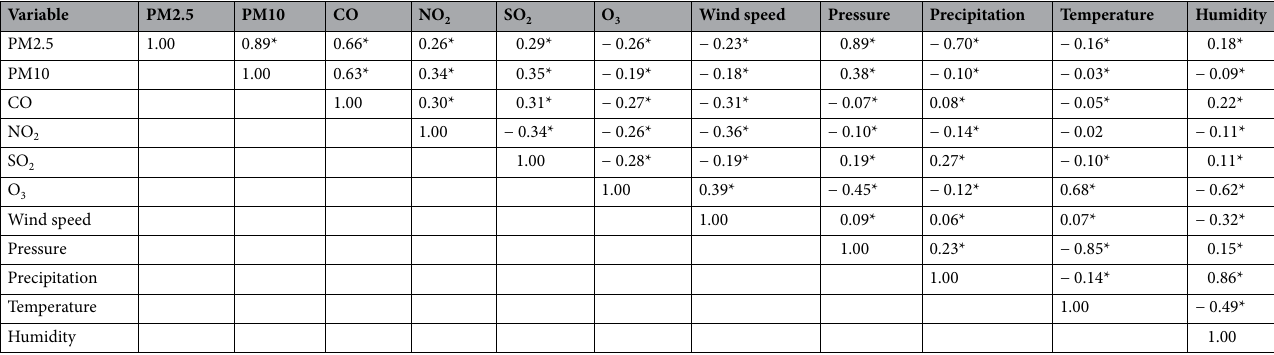
Table 2. Pearson linear correlation coefficients between six types of air pollutant concentrations and climate (Band * indicates significant correlation at a significant level of